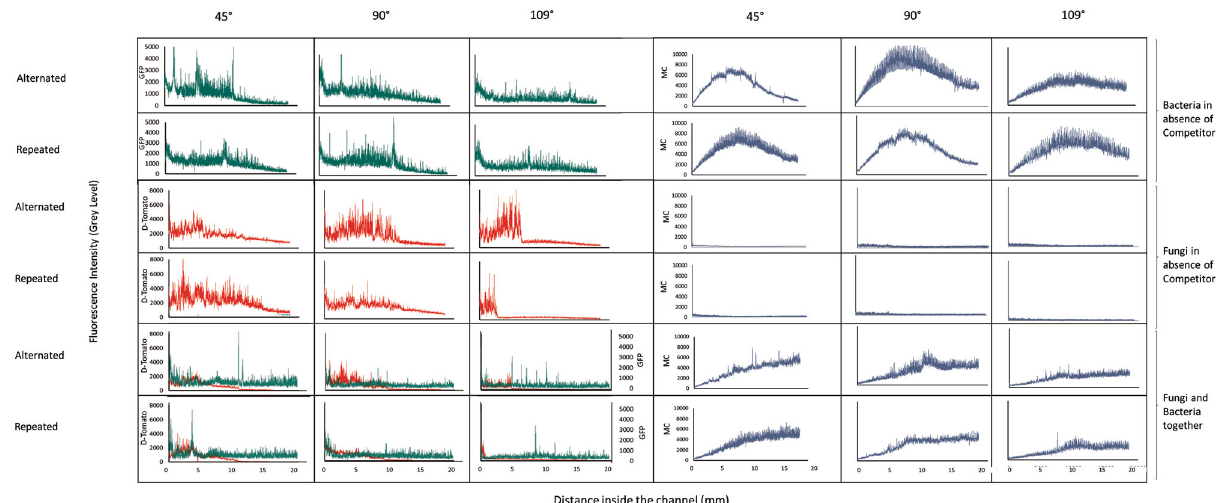
Fig. 4 Examples of fl uorescence pro fi les of P. putida expressing GFP constitutively (green), C. cinerea expressing d-Tomato constitutively (red), and 4-methylcoumarin (blue) inside the micro fl uidic channels. Pro fi les were obtained from the time point of highest fl uorescence, day 2 for P. putida and day 6 for C. cinerea and 4-methylcoumarin, after inoculation inside the micro fl uidic channels. The fl uorescence pro fi les show the changes in fl uorescence along the length of every type of channel studied under the two competitor conditions. The beginning of the channel is located on the left side of each plot. The data from which these pro fi les were obtained is included in Supplementary Data